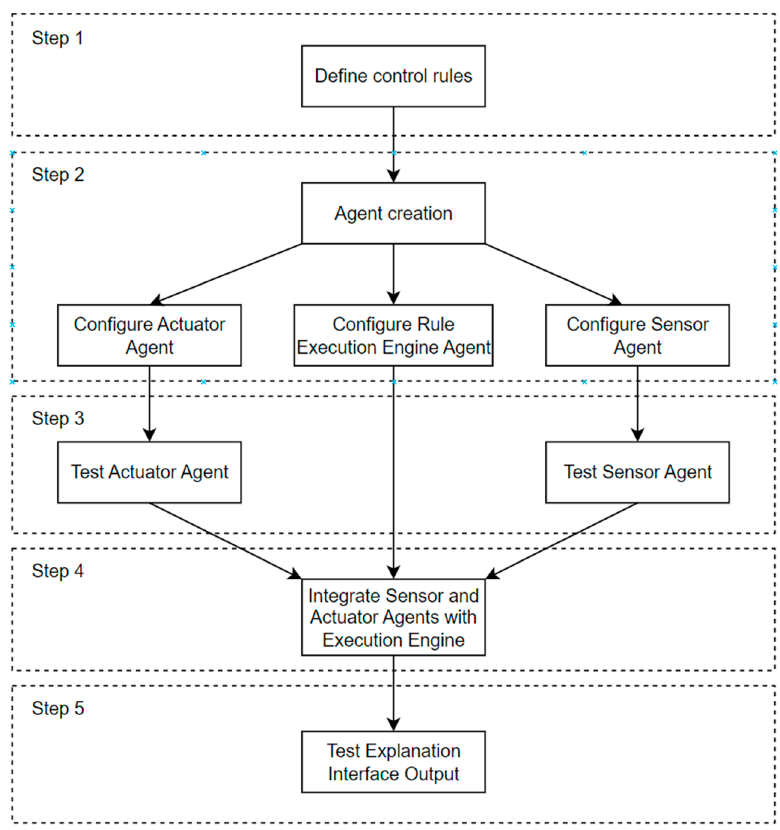
Figure 2. Method Figure 2. Method steps.